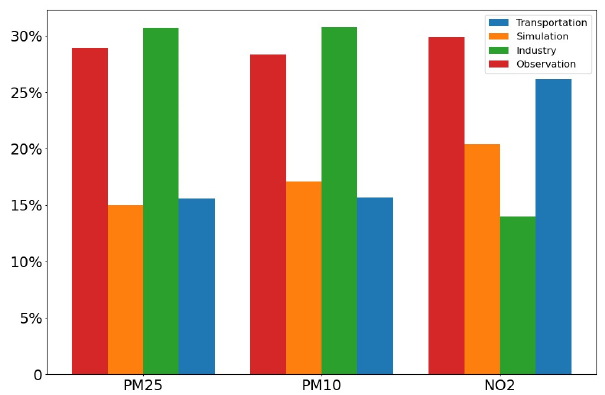
Figure 12. Proportional reduction in model-simulated pollutants observed pollutants, traffic emis- sions, and industrial emissions of pollutants concentrations during the LP.